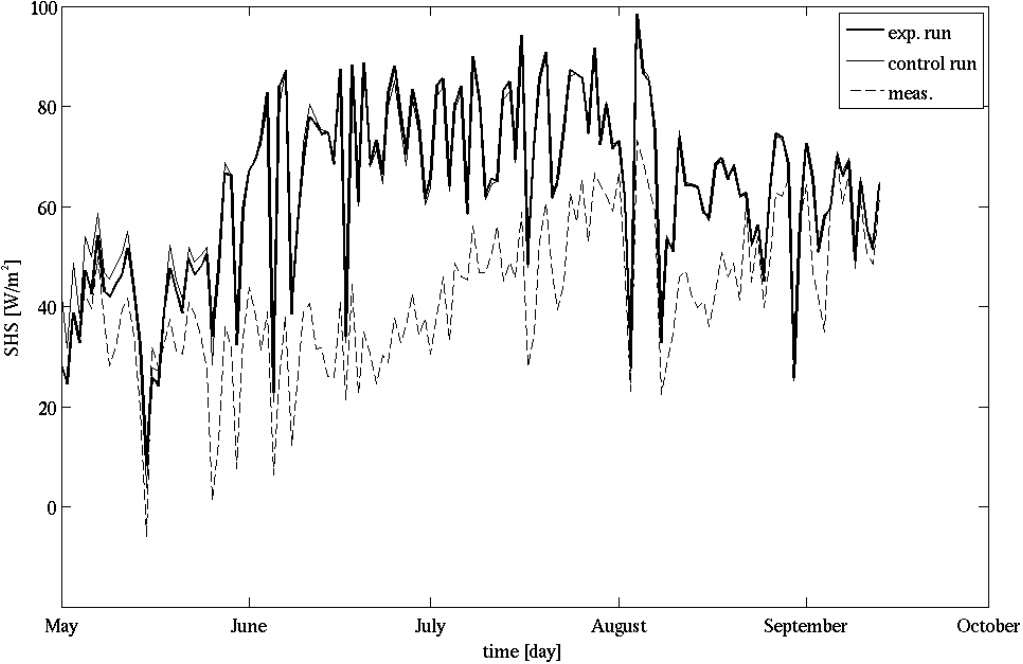
. Figure 11. Mean daily values of sensible heat flux (in Wm - 2 ) during the 2009 vegetative season. The dashed line shows the values derived from the measurements carried out with the sonic anemometer above the vineyards, the thick line refers to the experimental and the thin line to the control run.